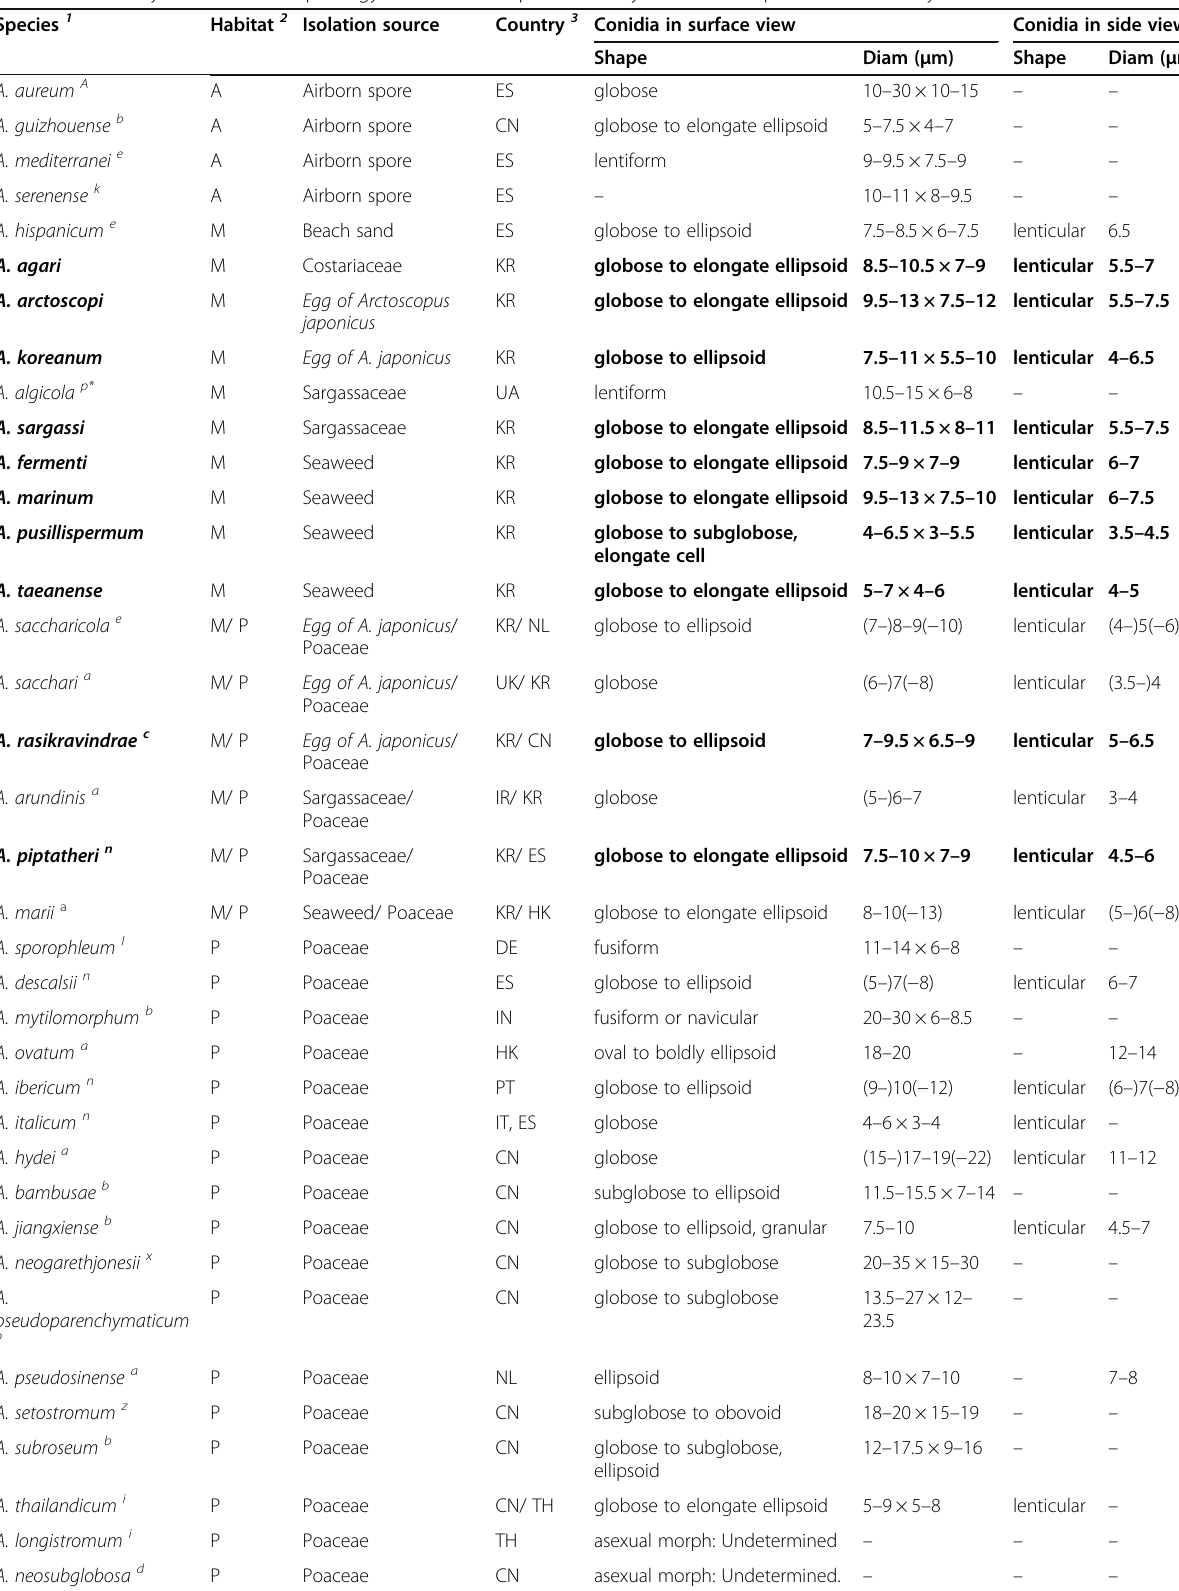
Table 2 Summary of conidial morphology of Arthrinium species. Newly established species in this study are shown in bold Species